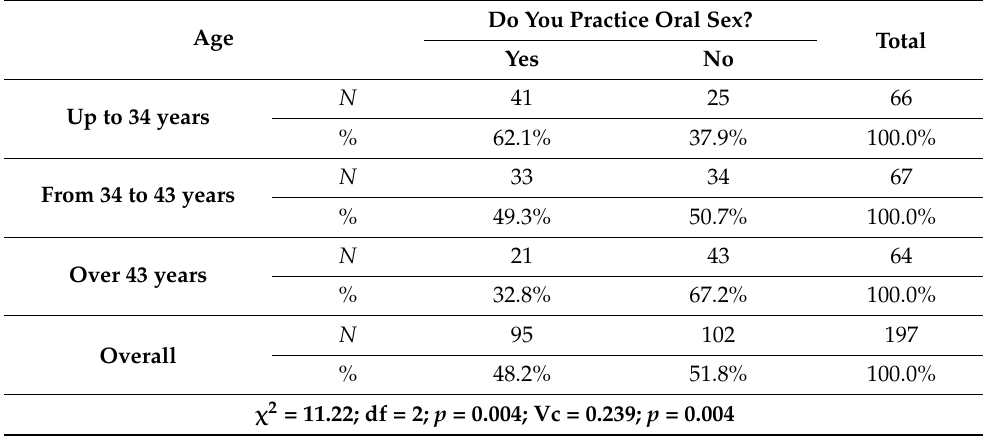
Table 8. Results from analyzing the relationship between the age of the respondents and the practice of oral